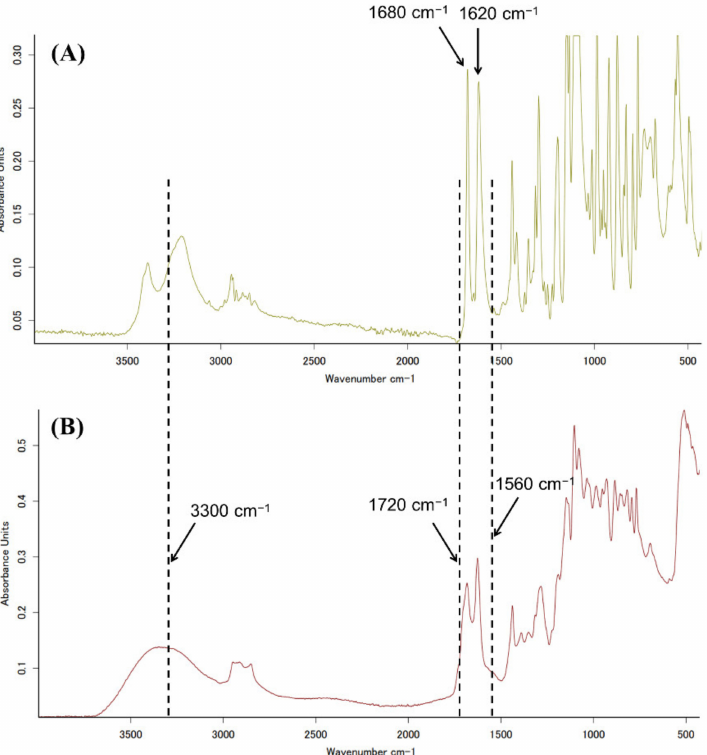
Figure 6. FTIR spectra of dried w-GE ( A ) and n-GE ( B ). Both the spectra were obtained with an ATR